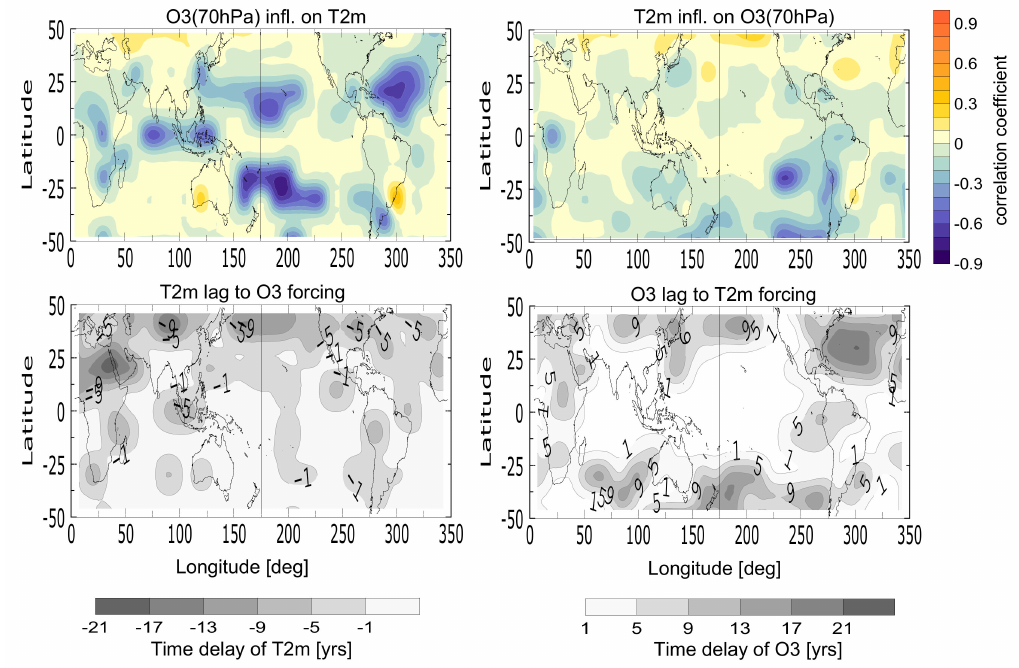
Figure 2. Correlation maps of the lower stratospheric ozone mixing ratio and temperature at 2 m above the surface (T 2m ), calculated for December–April during the period 1900–2010. The colored shading marks the lagged cross-correlation. The upper left panel illustrates the hypothesis for O 3 as an independent variable, while the upper right panel shows the strength of T 2m influence on the O 3 . The bottom panels show the spatial distribution of the time lag of dependent variables in